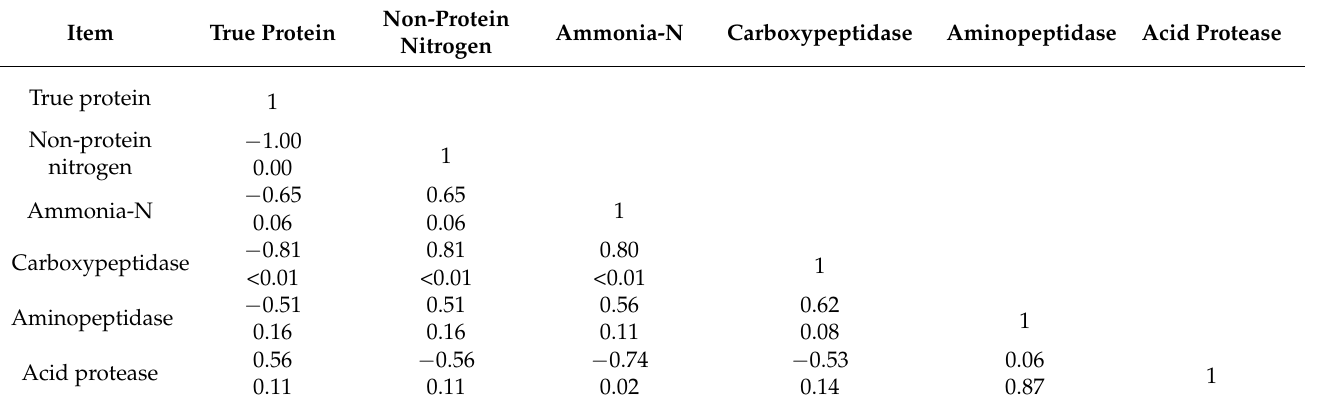
Table 4. Pearson’s correlations between protease activities and the protein fractions of mulberry leaf silages.